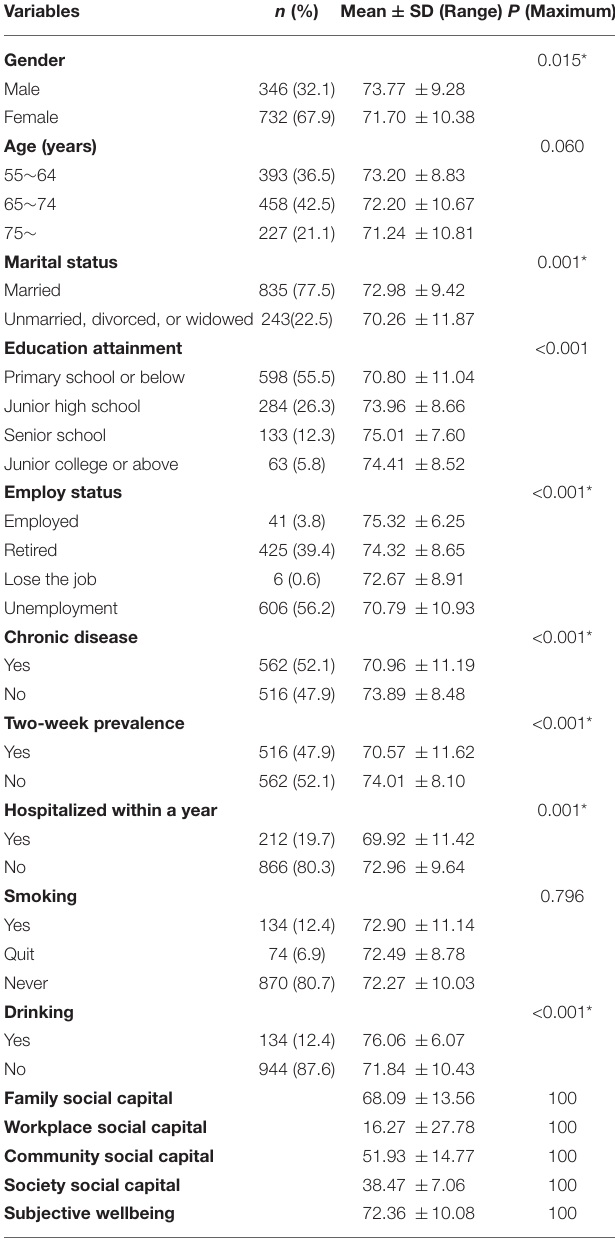
TABLE 1 | Subjective wellbeing among survey elderly participants ( n =